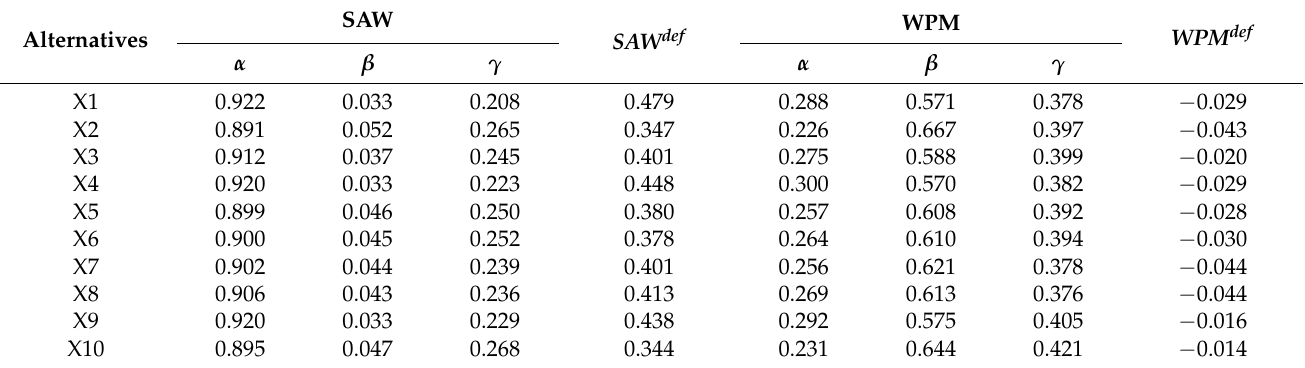
Table 14. Results of SAW and